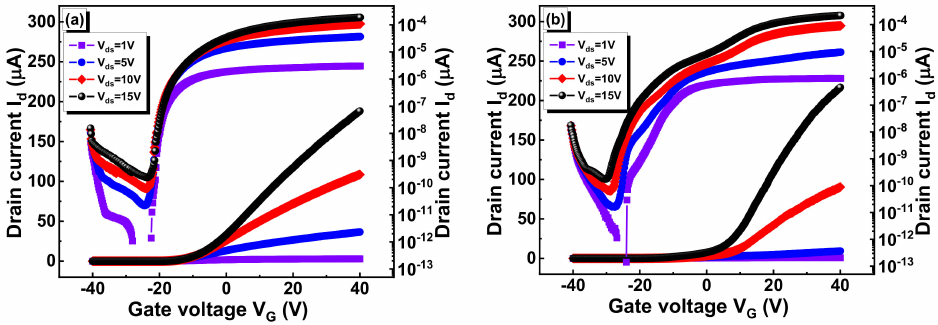
Figure 4. Transfer curves (I d -V G ) at various V ds values for MISFET devices of ( a ) MoSe 2 /SiO 2 /Si and ( b ) MoSe 2